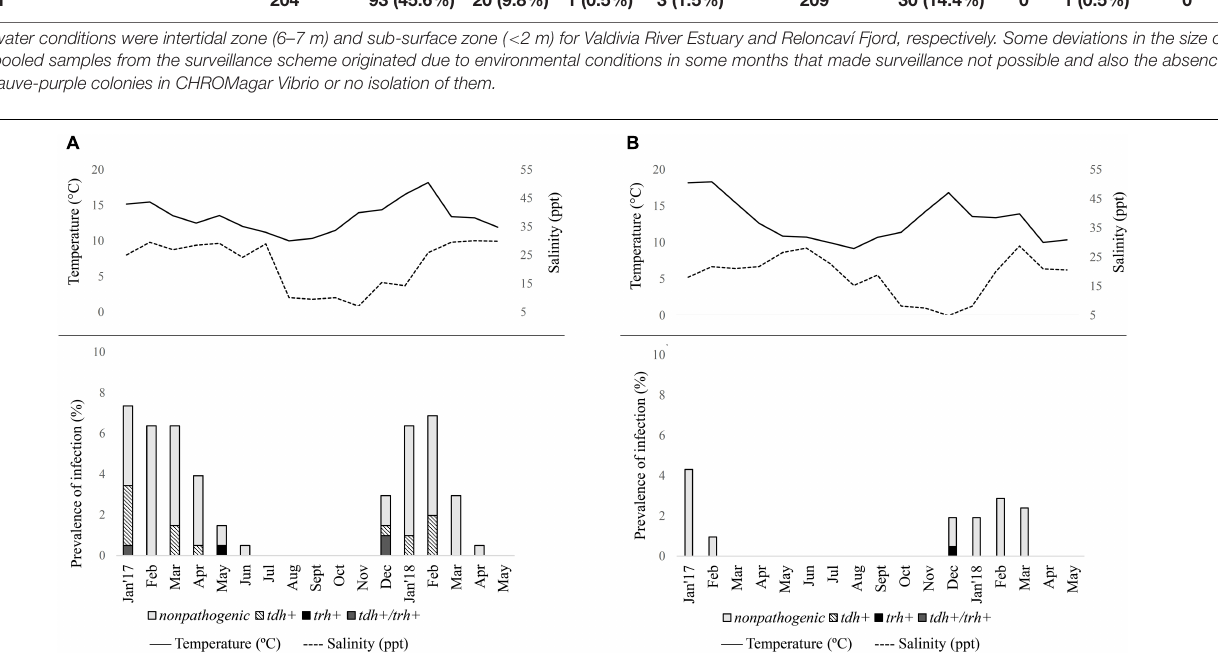
the rest of the fixed effect parameters showed P -values lower than 0.001 ( Table 5